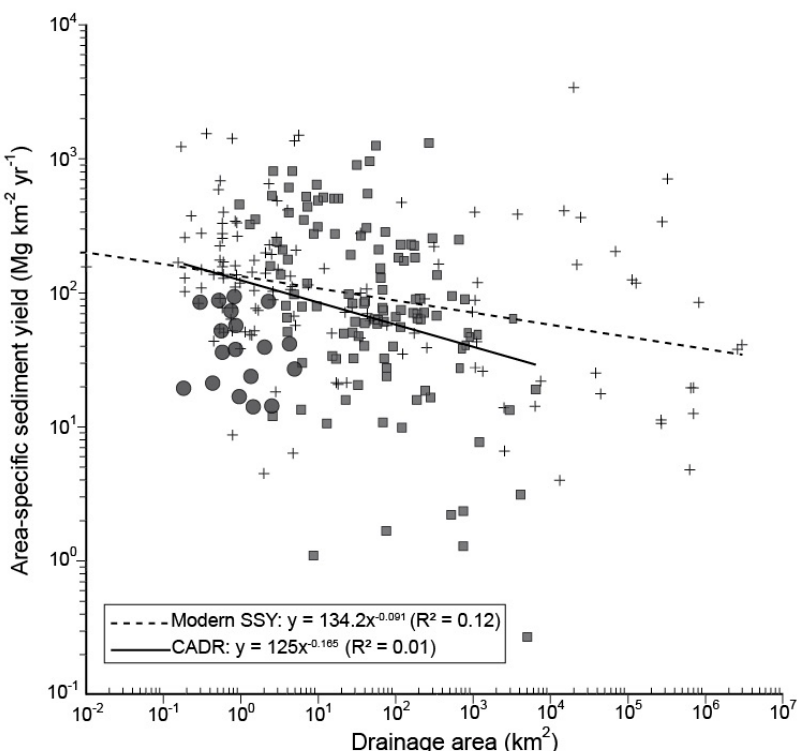
Figure 9. Comparison of the modern area-specific sediment yield in BWh climates (+ symbol) com- piled by Jeong and Dorn [33] with pre-anthropogenic background sediment yields obtained by 10 Be CADR measurements in this study (solid circles) and those compiled previously [90] for arid regions (solid